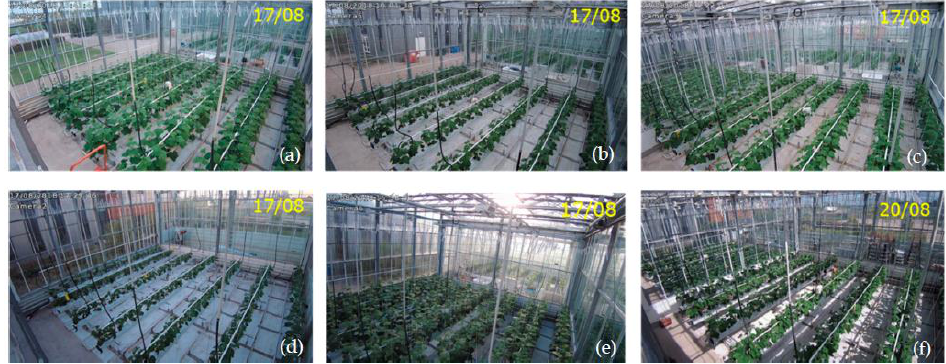
Figure A1. Young cucumber crop planted in the six greenhouse compartments, pictures of different stem densities chosen by teams: ( a ) iGrow; ( b ) deep_greens; ( c ) AiCU; ( d ) Sonoma; ( e ) Reference; ( f ) The Croperators.